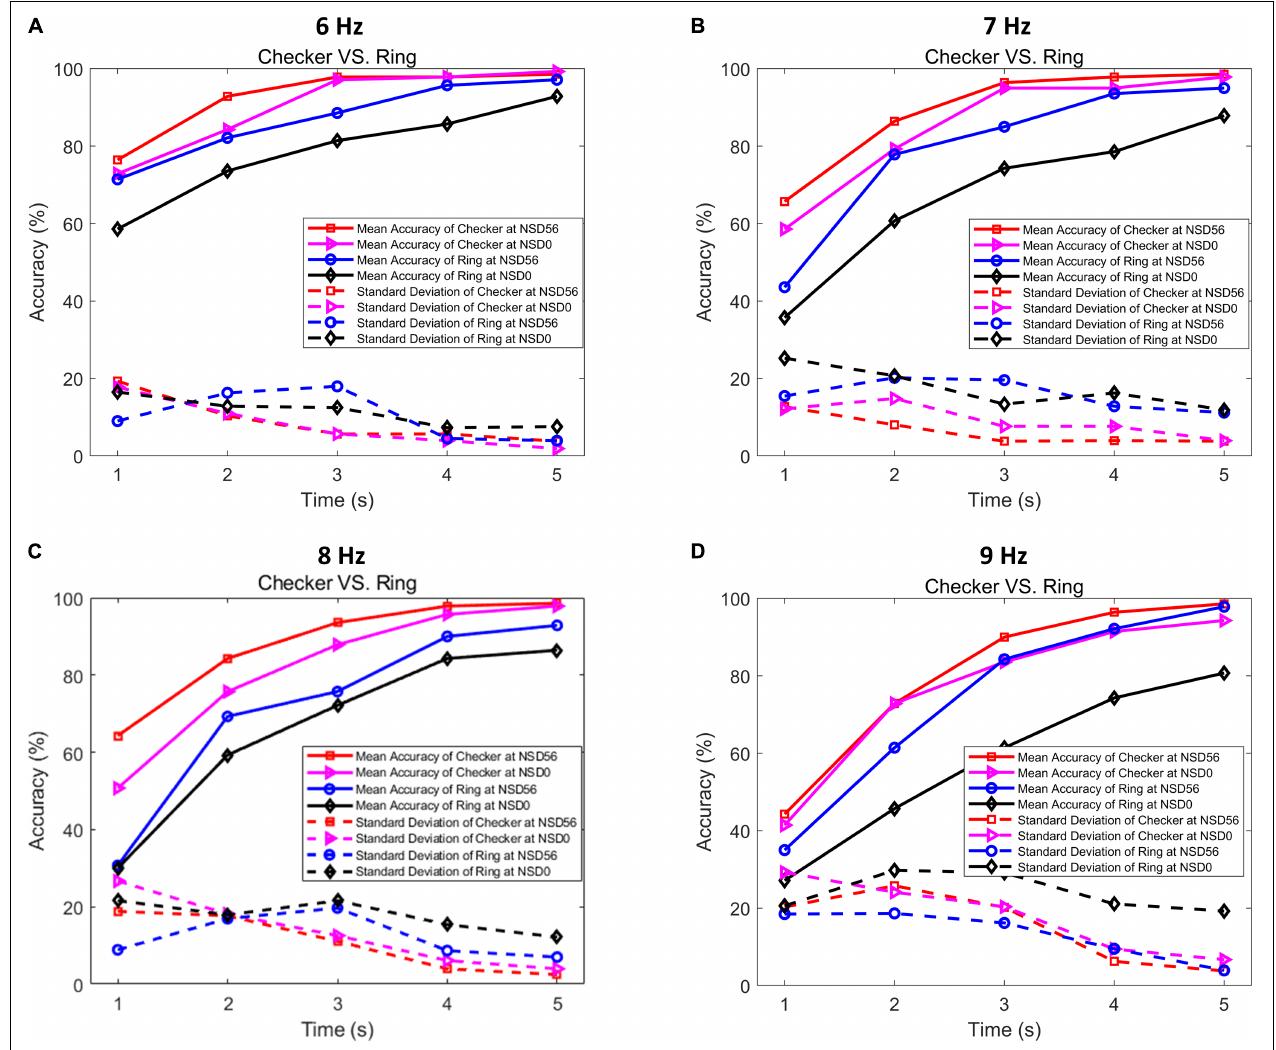
FIGURE 8 | Grand-averaged recognition accuracies and their standard deviations in checkerboard and single ring paradigms with different time-window lengths. (A) Averaged recognition accuracies and standard deviations at an MRF of 6 Hz. (B) Averaged recognition accuracies and standard deviations at an MRF of 7 Hz. (C) Averaged recognition accuracies and standard deviations at an MRF of 8 Hz. (D) Averaged recognition accuracies and standard deviations at an MRF of 9